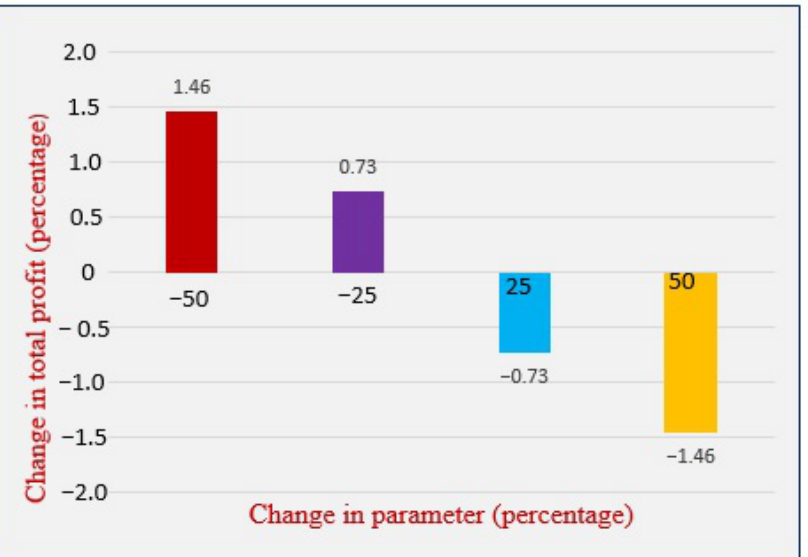
Figure 6. Effects of changes in parametric values versus total expected profit for the most sensitive parameter R p